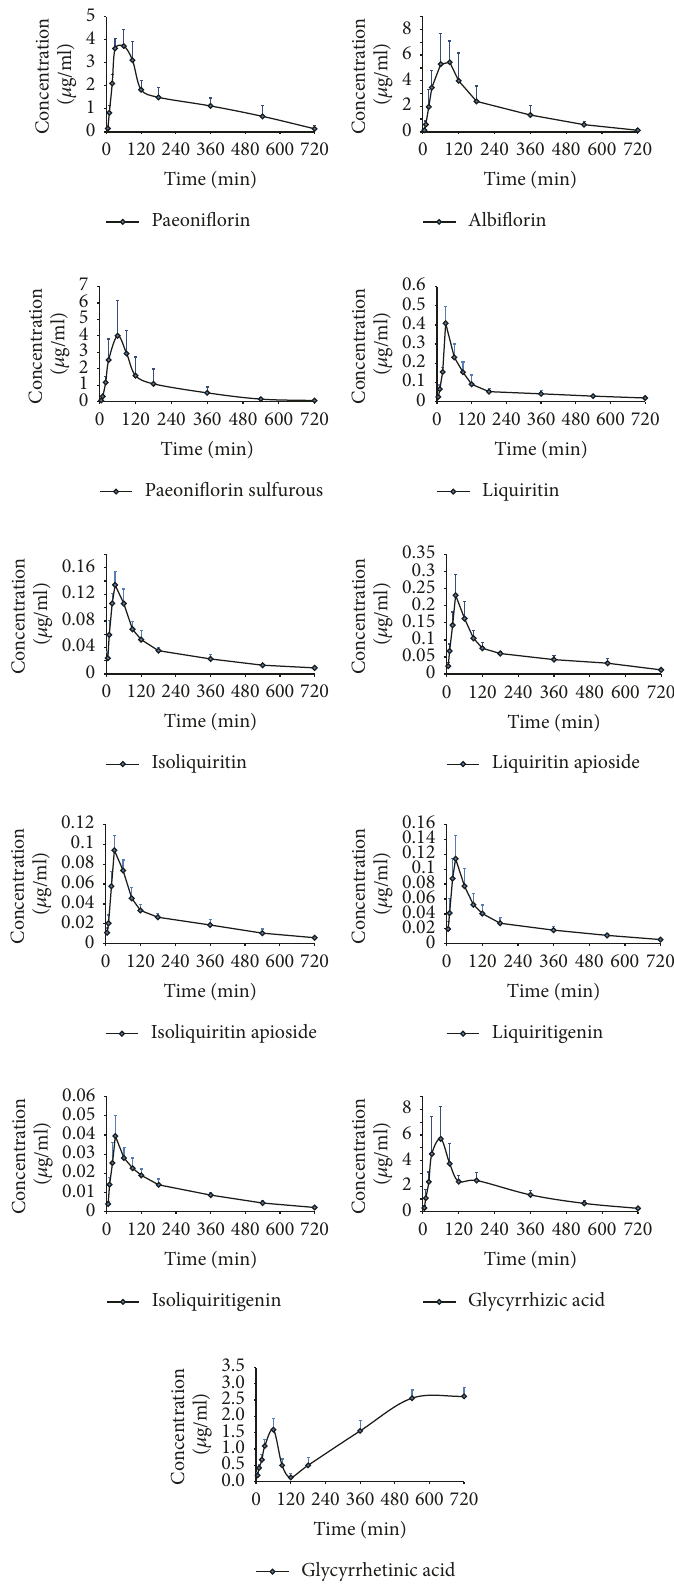
Figure 3: Concentration-time curve of 11 detected compounds in